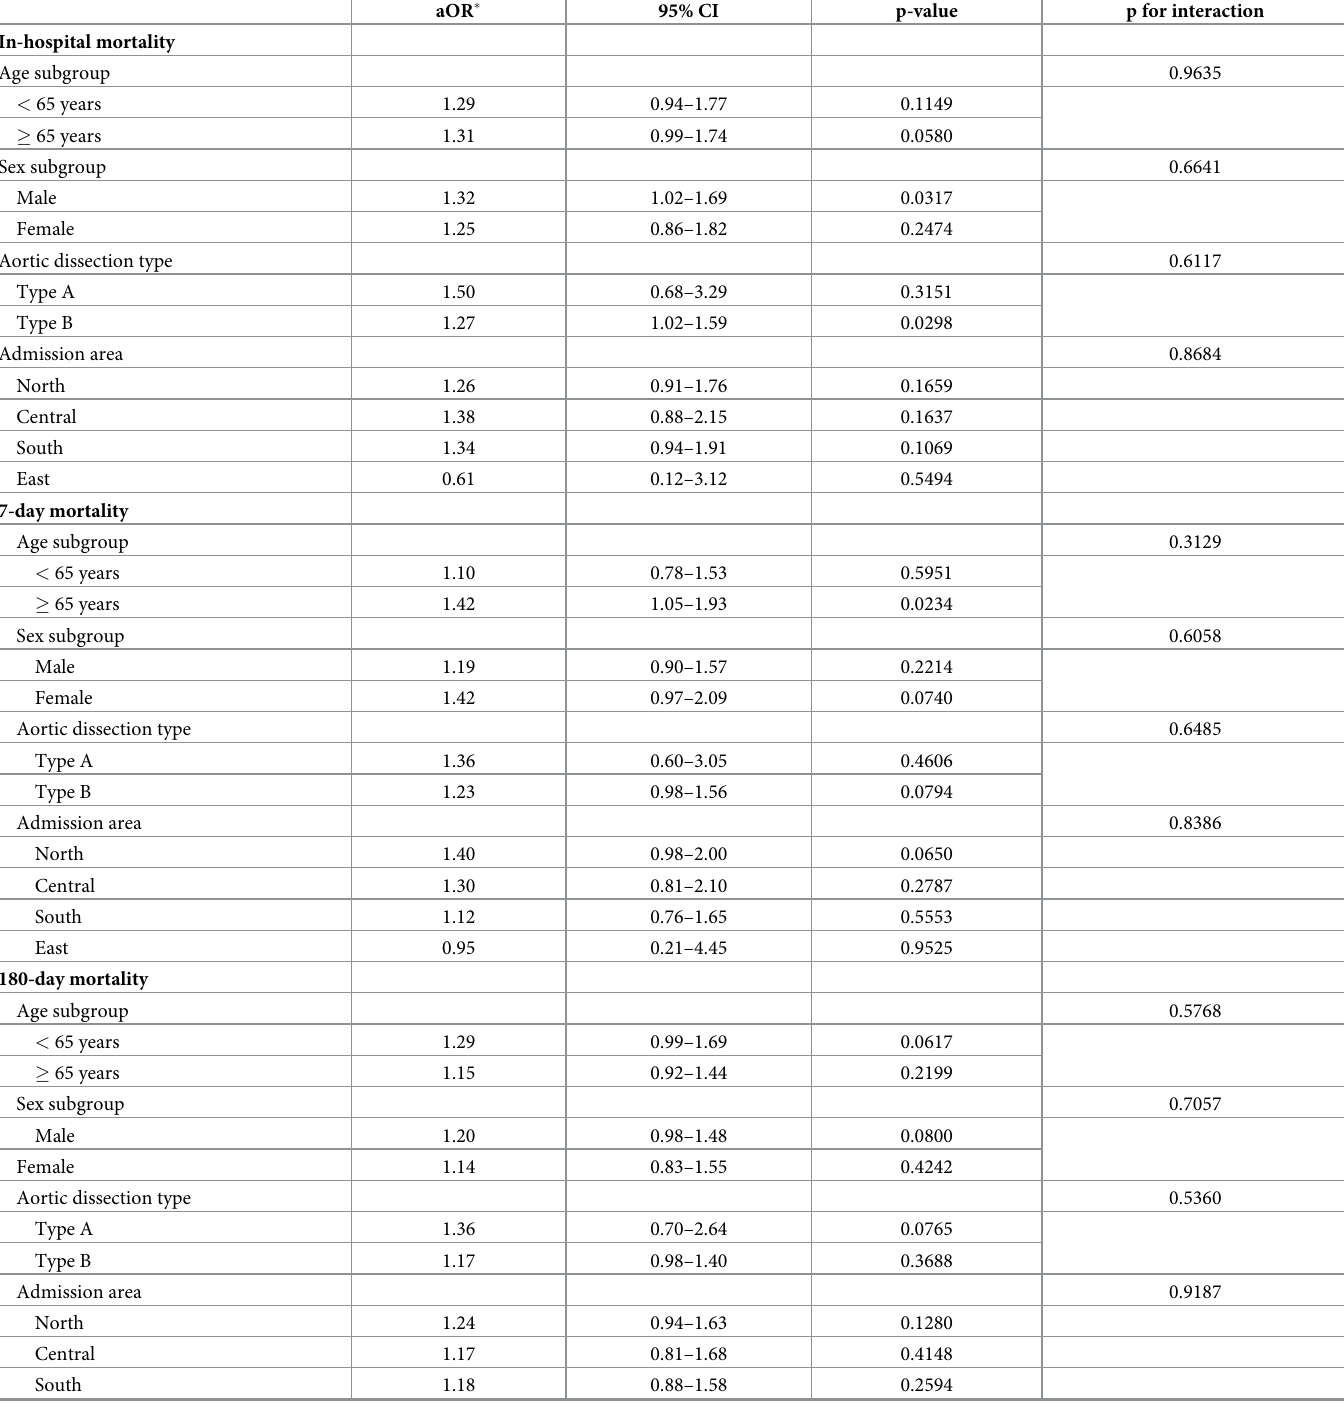
Table 4. Subgroup analyses for mortality risks among patients admitted for acute aortic dissection on the weekend compared to a weekday after stratification for age, sex, aortic dissection type, and hospital